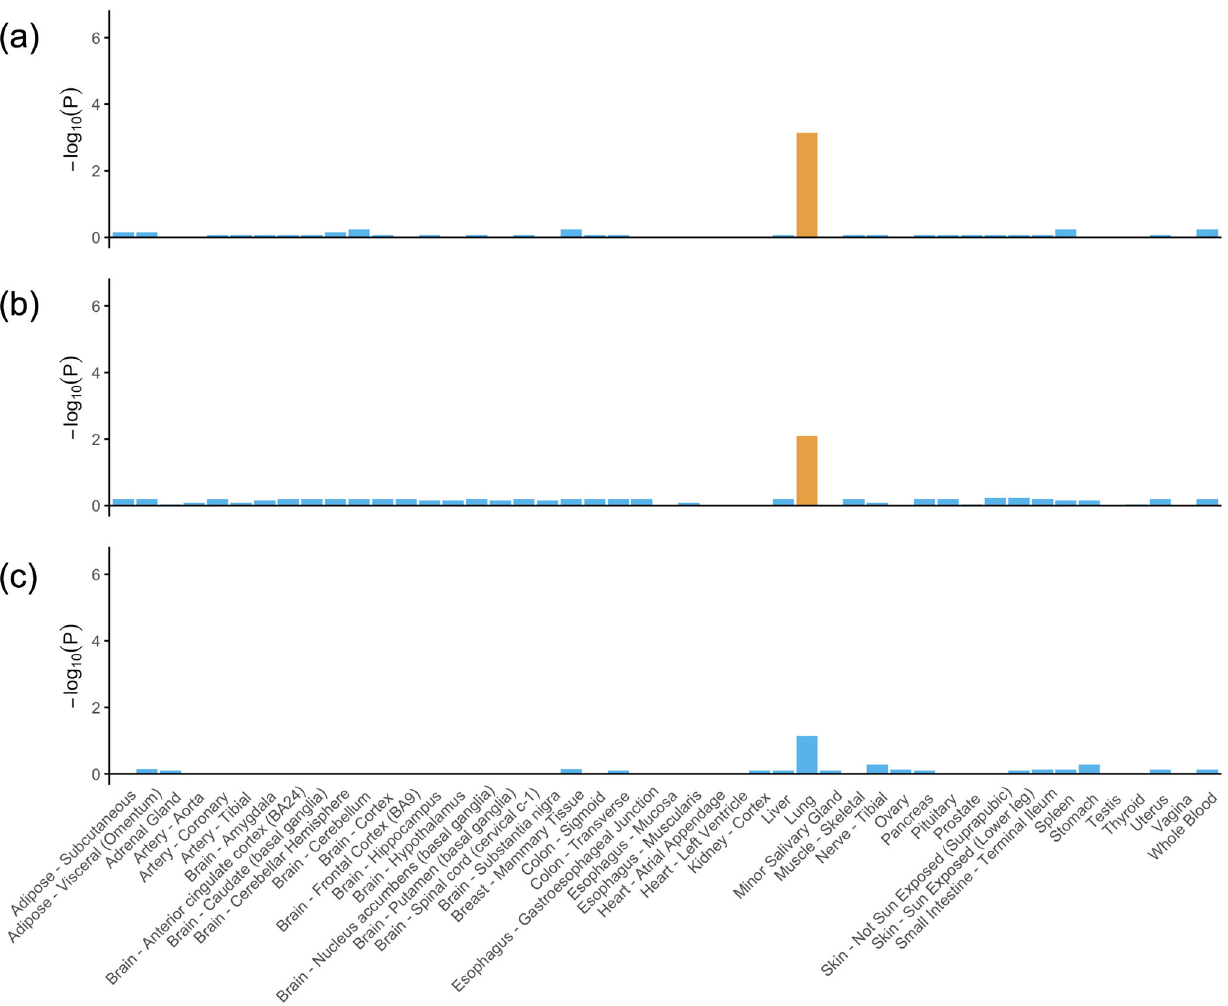
Fig. 4 GTEx tissue enrichment analysis for expression of shared signi fi cant genes (meta-analysis P value < 5 × 10 − 6 ). a VTE and severe COVID-19; b VTE and COVID-19 hospitalization; c VTE and SARS-CoV-2 infection. P values of Fisher ’ s exact test after Benjamin − Hochberg correction are presented in – log 10 scale. Orange represents signi fi cant tissue enrichment (Lung, P value = 7.16 × 10 − 4 for severe COVID-19 and VTE, P value = 8.20 × 10 − 3 for COVID-19 hospitalization and VTE). The presented data are available in Supplementary Data 11.